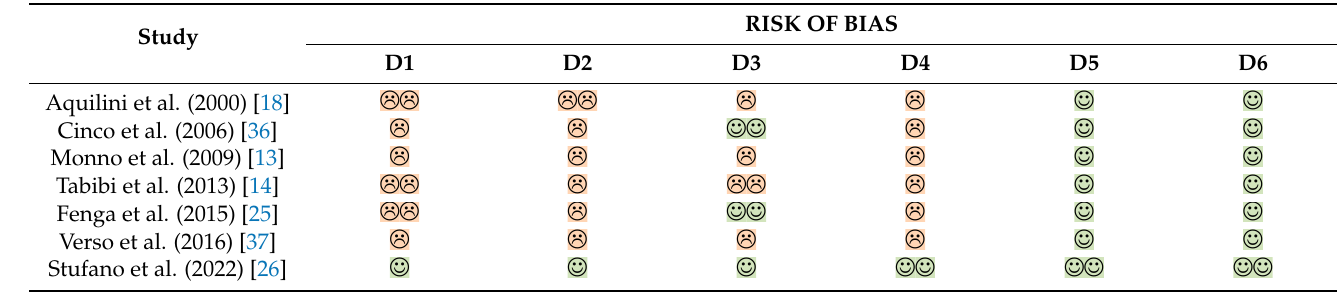
Table 3. Tabular representation for the Risk of Bias (ROB) assessment according to the National Toxicology Program (NTP)’s Office of Health Assessment and Translation (OHAT) handbook and respective risk of bias (ROB) tool [33,34]. Note: D1: possibility of selection bias; D2: exposure assessment; D3: outcome assessment; D4: confounding factors; D5: reporting bias; D6: other bias. = definitively high; = probably high; = probably low; = definitively low.